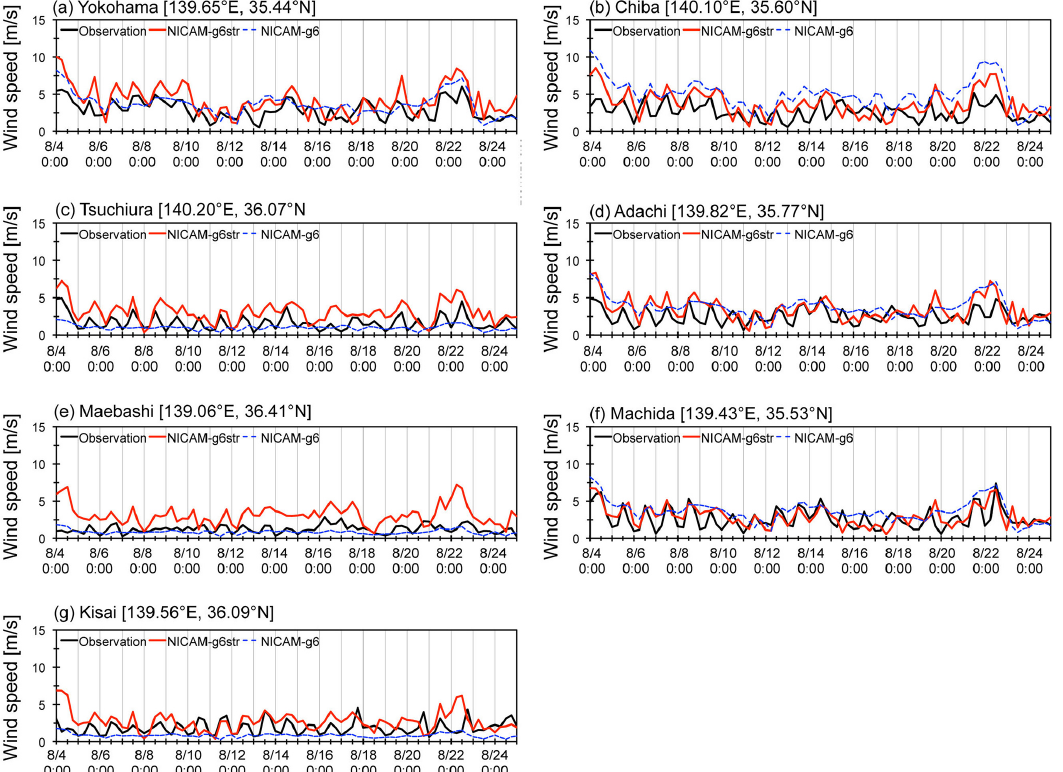
Figure 7. Same as Fig. 4 but for wind speed.